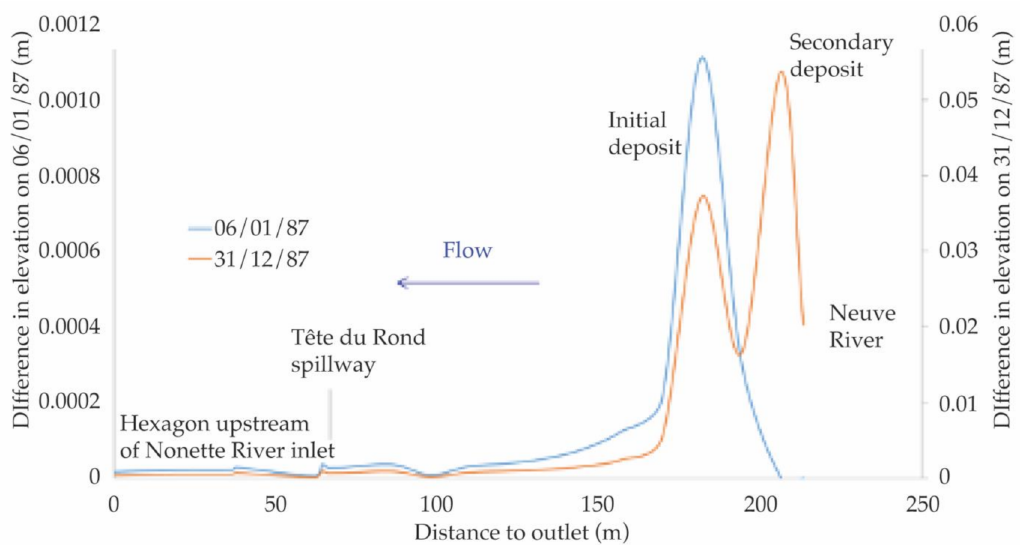
Figure 12. Calculated longitudinal profile of the deposition height upstream of GC on 6 January 1987.